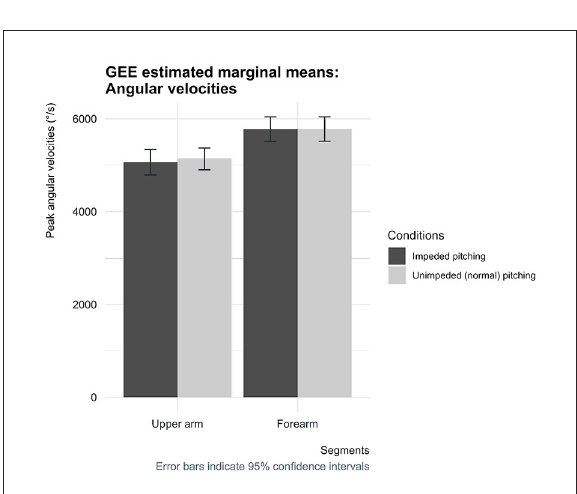
FIGURE8 Estimated marginal means for the peak angular velocities of the upper arm and forearm for both conditions with corresponding 95% confidence interval error